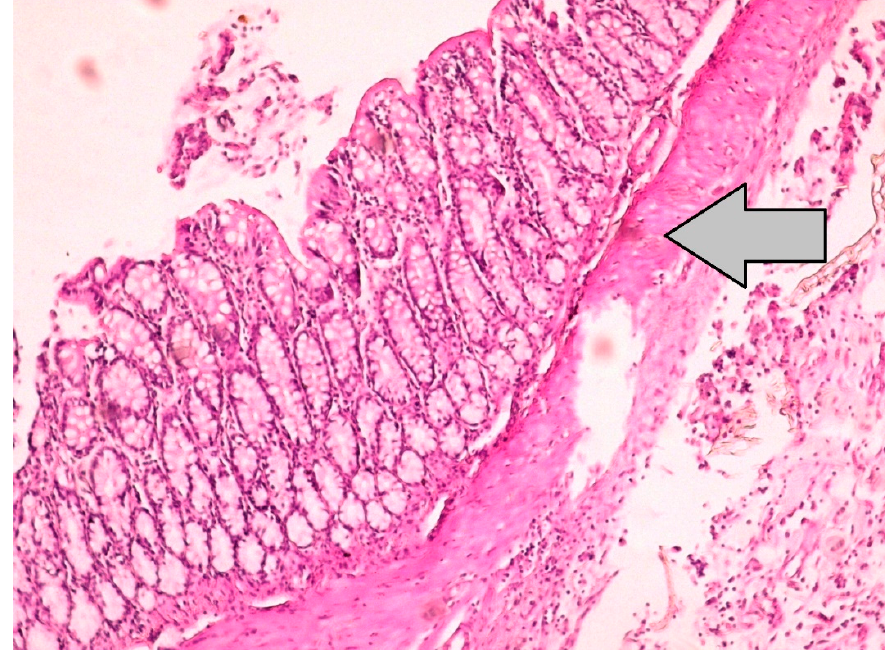
Figure 2. Histopathological image, which represents the grade 3 reepithelization at the anastomotic line of the Sham-S group, demonstrates the large intestinal mucosa, with the epithelial layer precisely seen on the surface of the colon anastomosis (H&E × 100).